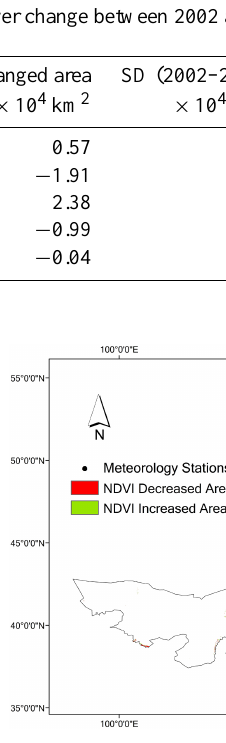
Figure 4. The cumulated NDVI trend in permanent grassland from 2002 to 2014. The green parts represent the increasing area, while the red parts represent the decreasing